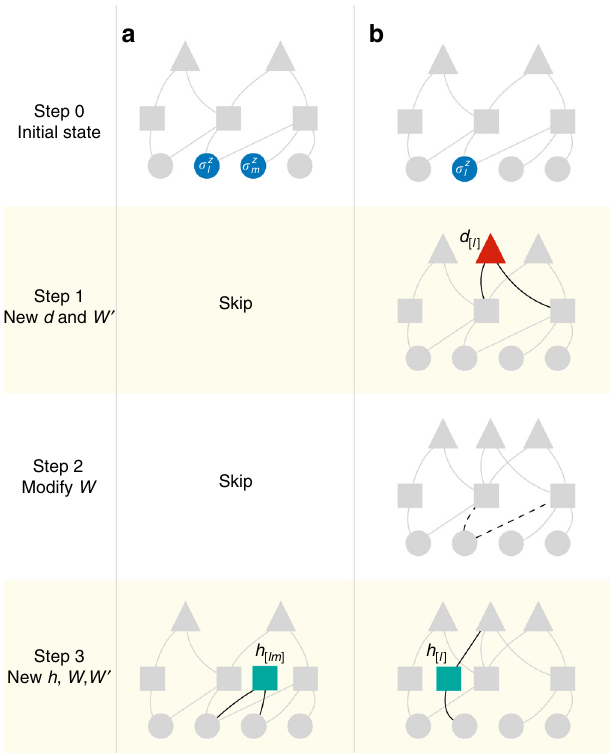
Fig. 2 Construction of exact DBM representations of the transverse- fi eld Ising model. In this example, a step of imaginary-time evolution is shown, for the case of the one-dimensional transverse- fi eld Ising model. Dots (cid:5) (cid:6) represent physical degrees of freedom σ z i , squares represent hidden units ( h j ), triangles represent deep units ( d k ). In each panel, upper networks are the initial state with arbitrary network form, and the bottom networks are the fi nal states, after application of the propagator. Intermediate steps illustrate how the network is modi fi ed, where the relevant modi fi ed couplings at each step are highlighted in black. The highlighted solid and dashed curves indicate new and vanishing couplings, respectively. a Shows the diagonal (interaction) propagator being applied to the highlighted blue spins. This introduces a hidden unit (green) connected only to the two physical spins. In ( b ) the off-diagonal (transverse- fi eld) propagator is applied, acting on the blue physical spin. Here, we then add one deep unit (red triangle), and a hidden unit (green) mediating visible – deep